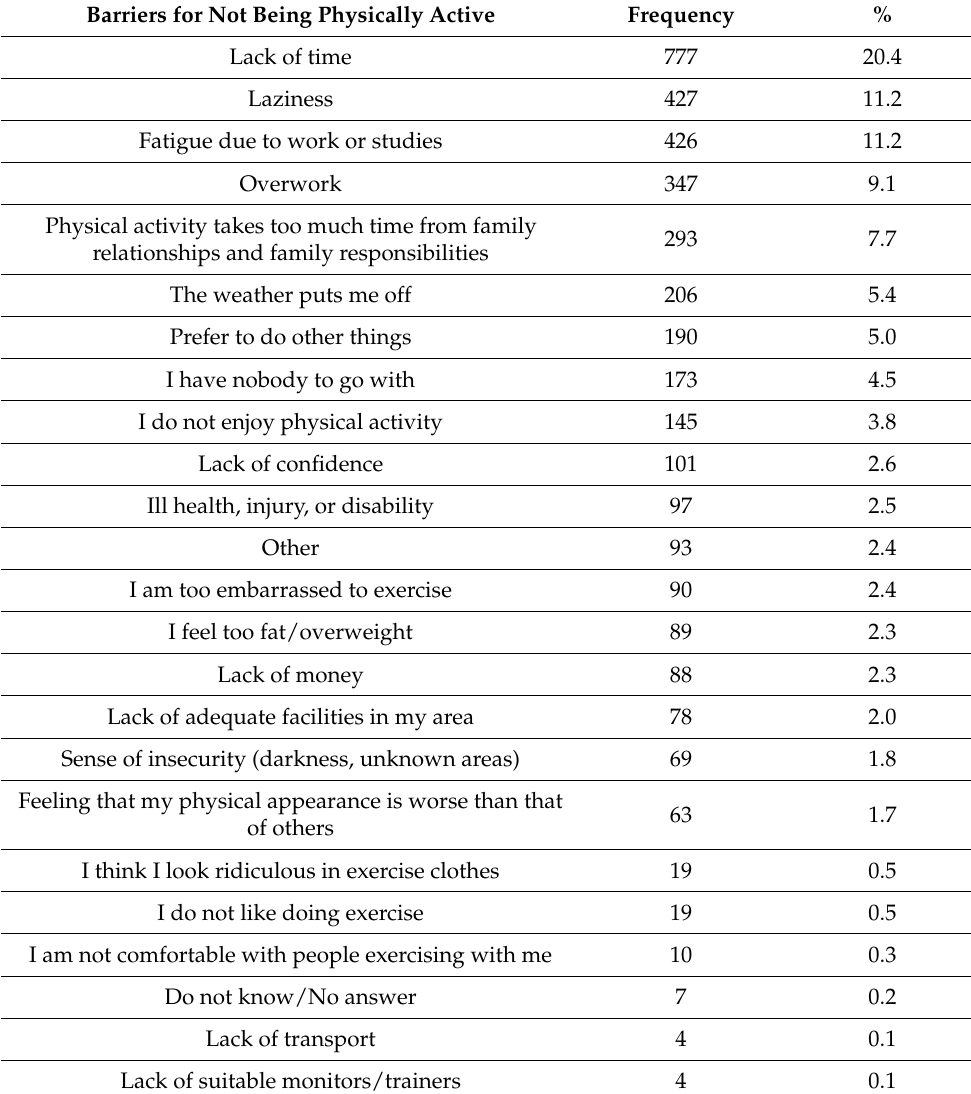
Table 3. Responses of participants in the inactive group regarding barriers to LTPA ( n = 1137 women, total responses =